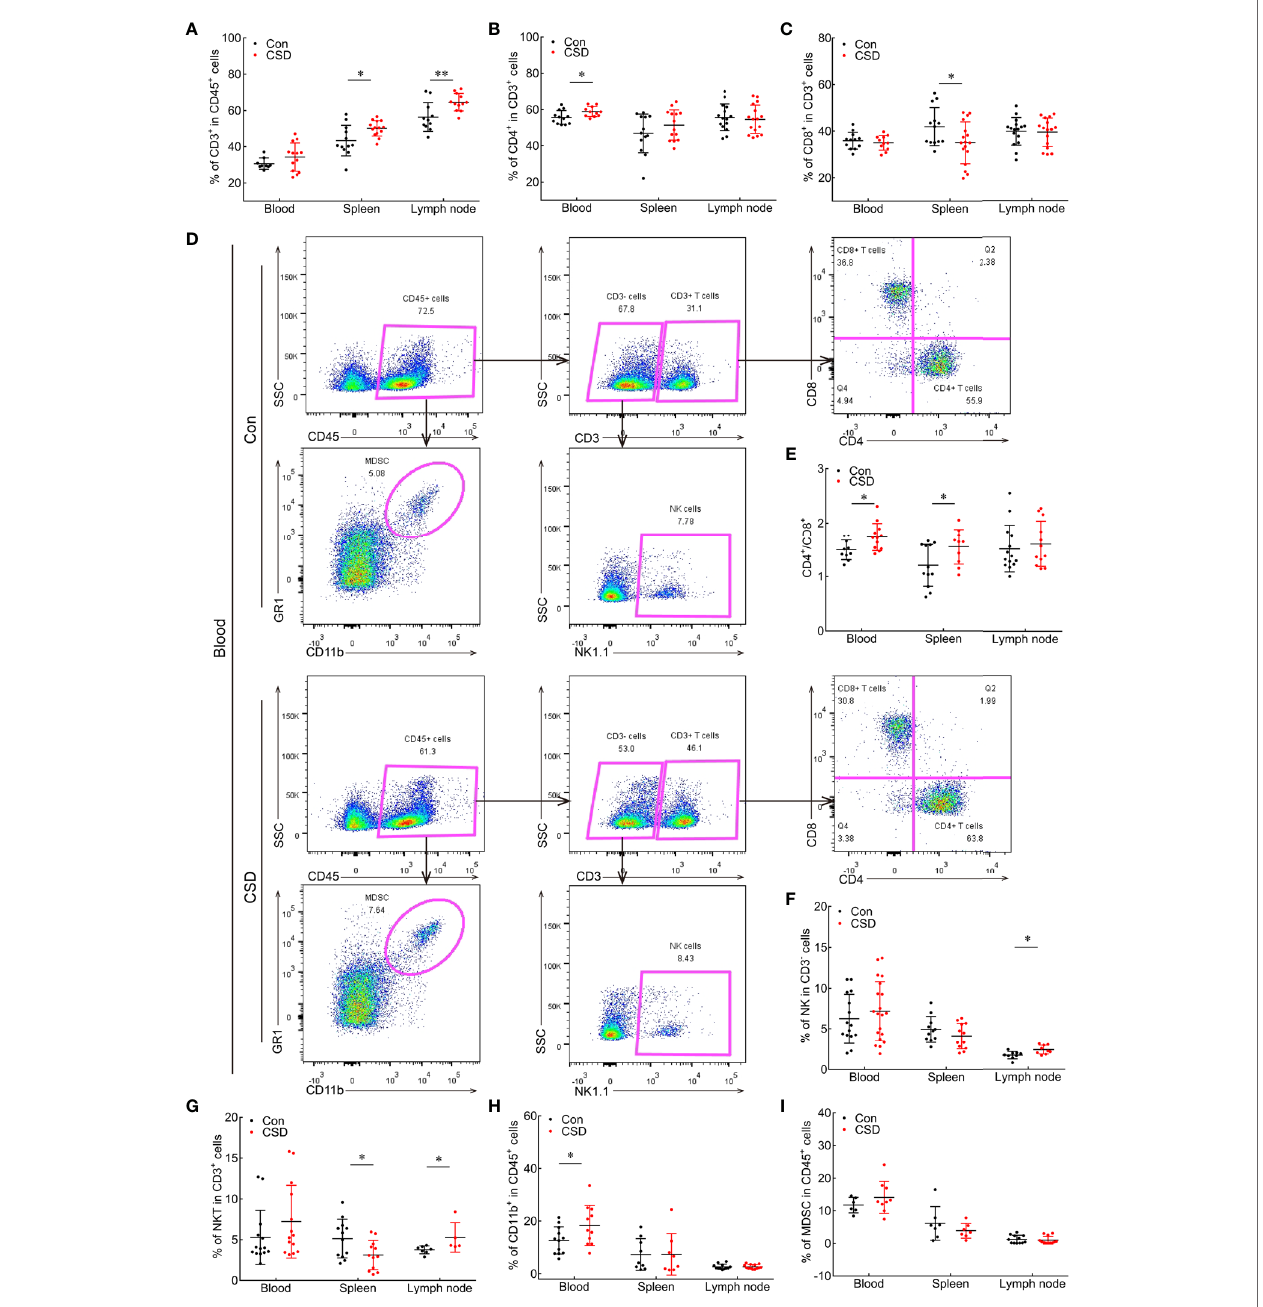
FIGURE 2 | Effect of CSD on the proportions of immune cells in the peripheral blood, spleen, and lymph node of mice. (A – C) Quanti fi cation of CD3 + T cells (A) , CD4 + T cells (B) , and CD4/CD8 ratio (C) in the blood and peripheral immune organs. (D) Representative gating strategy in multicolor fl ow cytometry and scatterplots of immune cell subsets in the blood of CSD and Con groups. CD45 + cells were fi rst gated for the total population of white blood cells. CD45 + CD11b + GR1 + cells are presented as MDSCs; CD3 + CD4 + CD8 − and CD3 + CD4 − CD8 + cells were de fi ned as CD4 + T cells and CD8 + T cells, respectively; and CD3 - NK1.1 + cells were gated as NK cells. (E – I) Comparisons of CD4/CD8 ratio (E) and proportions of NK cells (F) , NKT cells (G) , CD11b + cells (H) , and MDSCs (I) in the blood, spleen, and lymph node between CSD and Con groups. Data are presented as mean ± SEM. * p < 0.05, ** p <